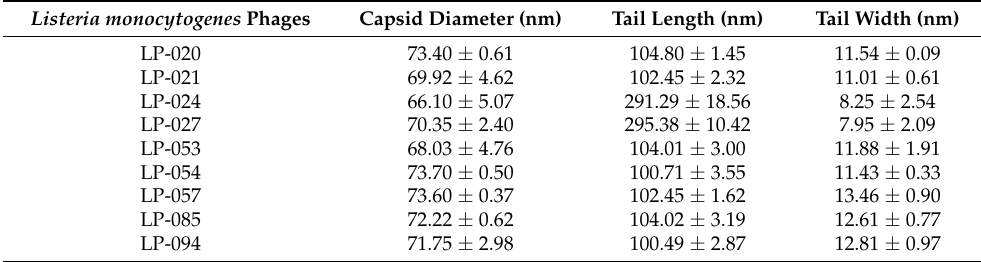
Figure 1. Transmission electron microscopy images of Listeria phages representing two morphologies: ( A ) LP-020 and ( B ) LP-094, characterized by an icosahedral capsid and a flexible, non-contractile tail; ( C ) LP-027, characterized by an icosahedral capsid and a long, flexible, non-contractile tail. Phages were stained with 1% phosphotungstic acid (pH &) and imaged at a final magnification of × 69,700–83,600. Images were analyzed using FIJI 3 (v2.0.0-rc-69/1.52p). Table 3. Morphology of Listeria monocytogenes